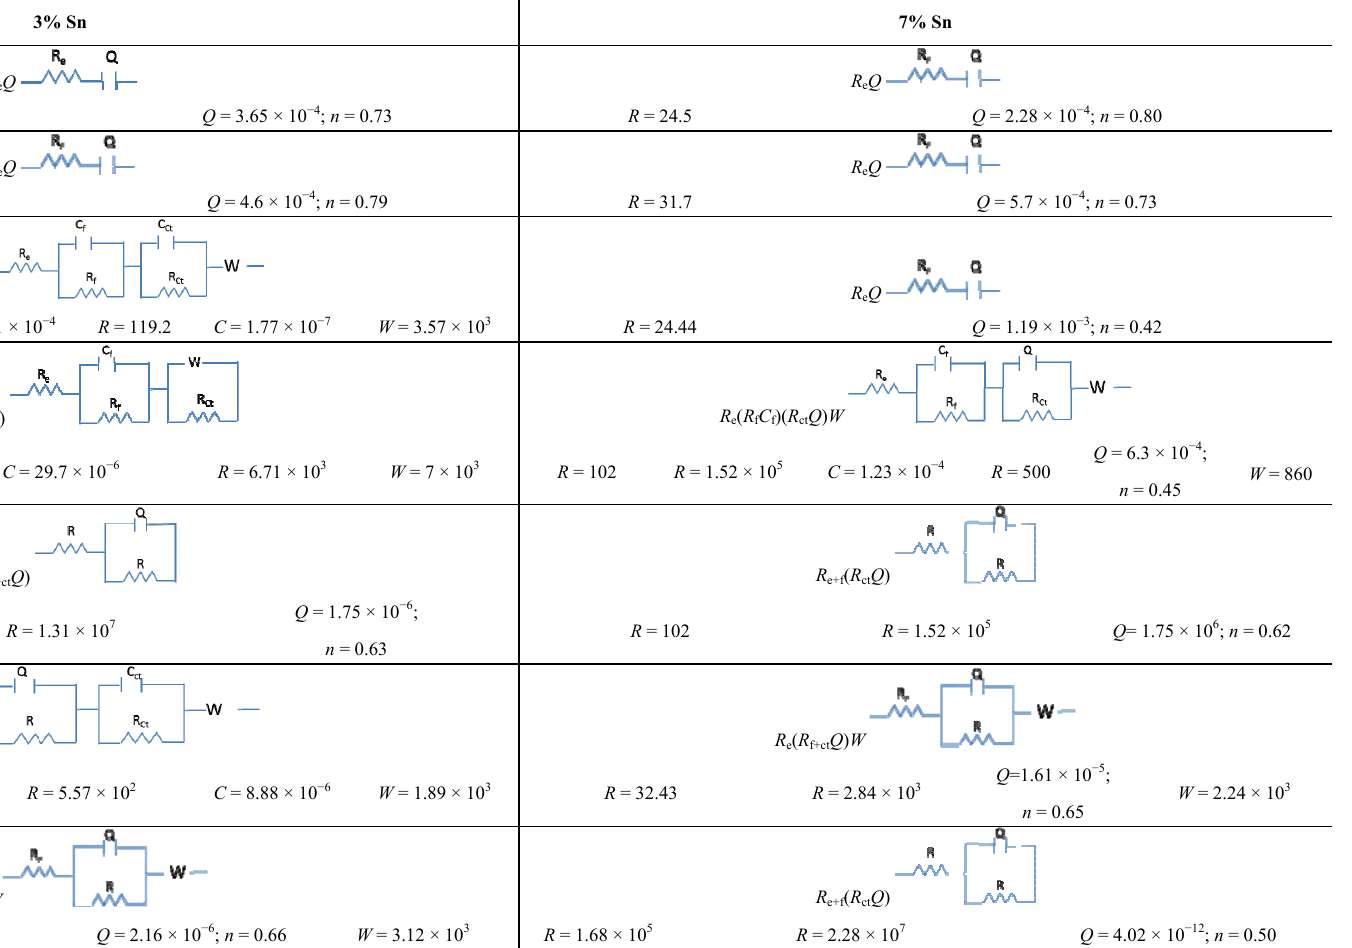
Table 2. Equivalent circuits for 3% Sn bronze and 7% Sn bronze immersed in 0.1 M sulphuric acid solution. The film resistance ( R capacitance ( C ); the resistance ( R ) and capacitance ( C ) of charge transfer; the resistance of the electrolyte ( R f ct ct phase element ( Q ) and its index n (present only with Q